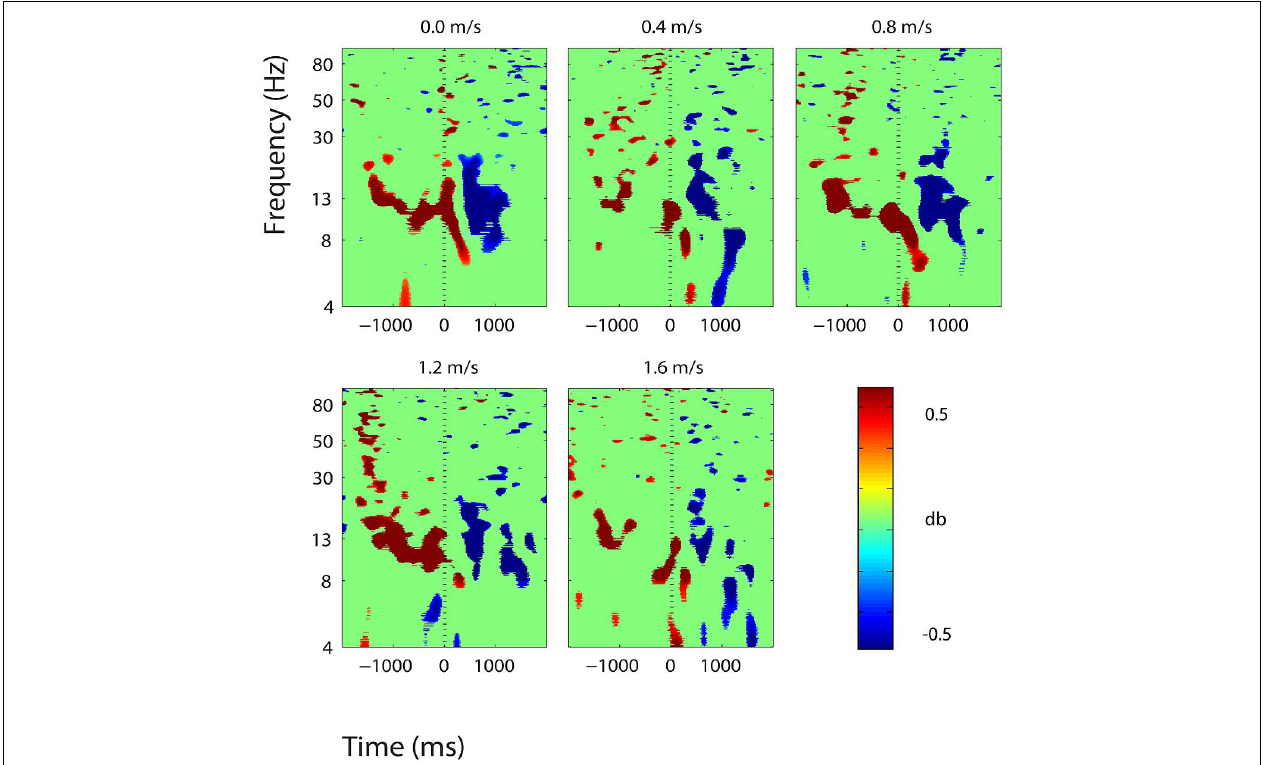
FIGURE 7 | Event-related spectral perturbation plots showing power change around the presentation of a stimulus (a digit and its position in an imagined grid) in the right somatosensory association cortex (BA 7). Red represents a power increase from